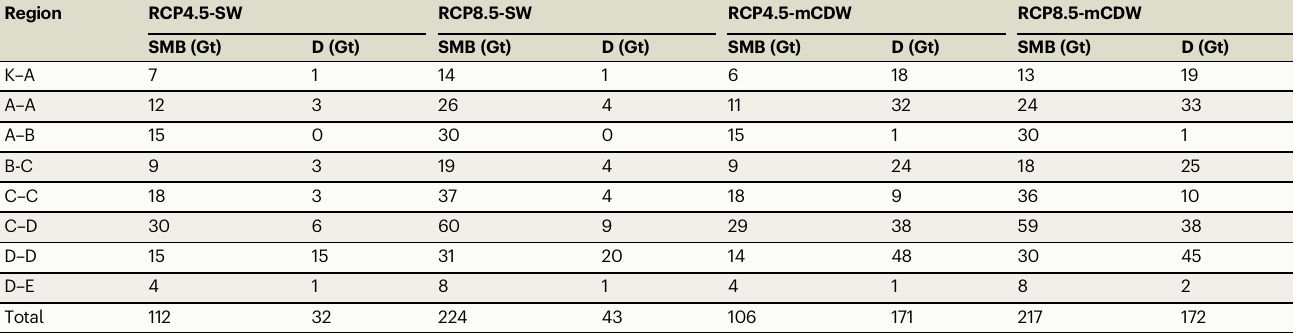
Table 2 | Surface mass balance and ice discharge for the four climate forcing scenarios after 100 years of simulation time Region